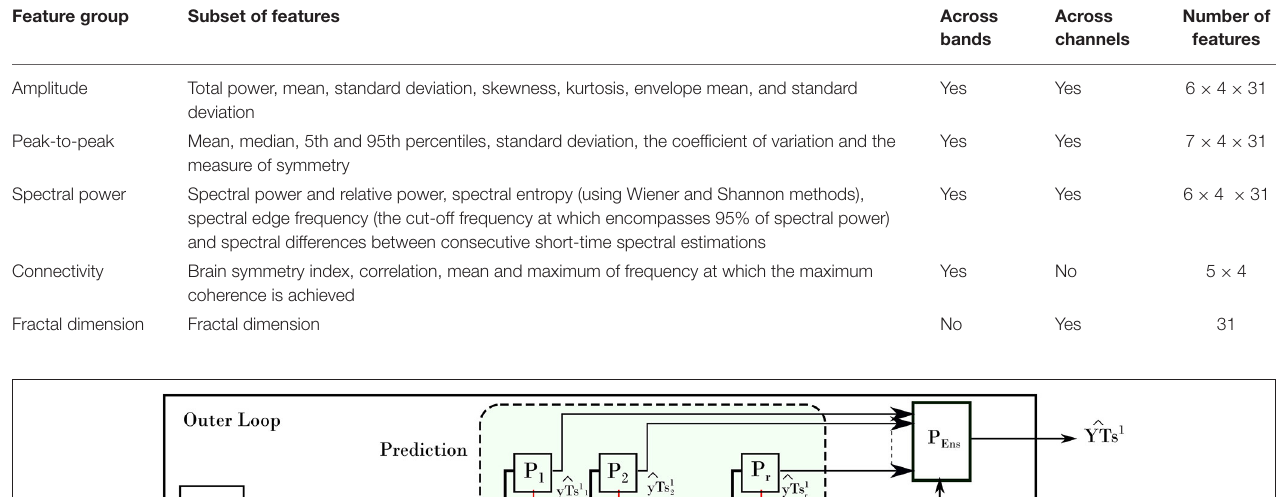
TABLE 2 | The extracted features from EEG data. Feature group Subset of features Across